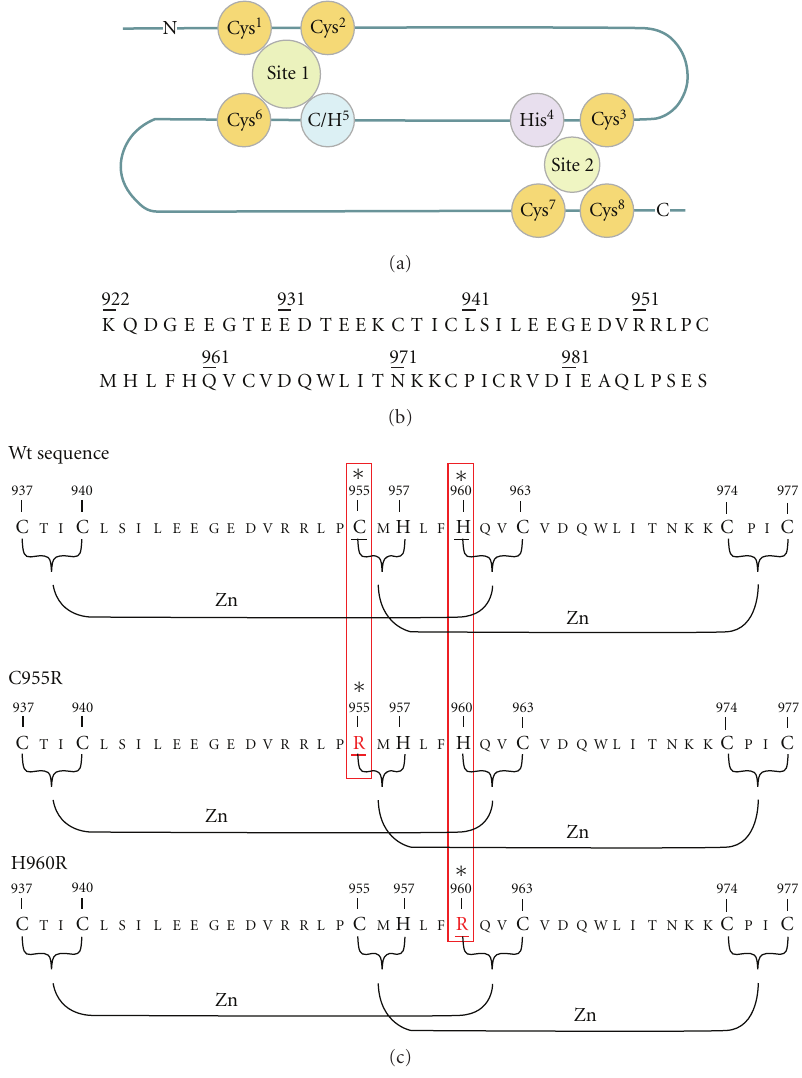
Figure 1: (a) The schematic structure of a RING finger domain showing the “cross-brace” arrangement of the two zinc binding sites; (b) The amino acid sequence of the RING finger domain of mouse Arkadia; (c) the mutation sites, C955R and H960R, in the sequence of Arkadia RING Finger